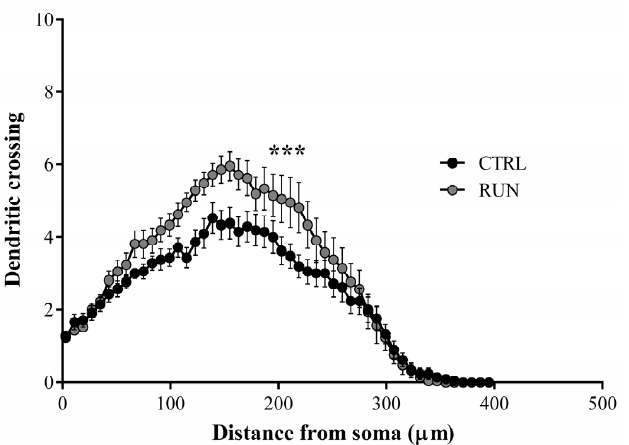
Figure 6. Sholl’s analysis of dentate gyrus GFP-positive neurons. Dendritic length measured by Sholl’s analysis (superimposed ring 8 µ m) revealed an increase in arborization, particularly evident at distances between 115–227 µ m from the soma in the RUN group. Data statistical analysis: multiple Student’s t -test, *** p < 0.001 from 115 to 227 µ m. All data are expressed as mean ± SEM, CTRL n = 21, RUN n = 21.